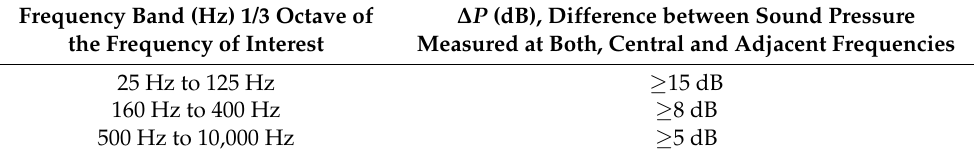
Table 1. Characterization of a tonal sound according to the ABNT NBR 10151:2019